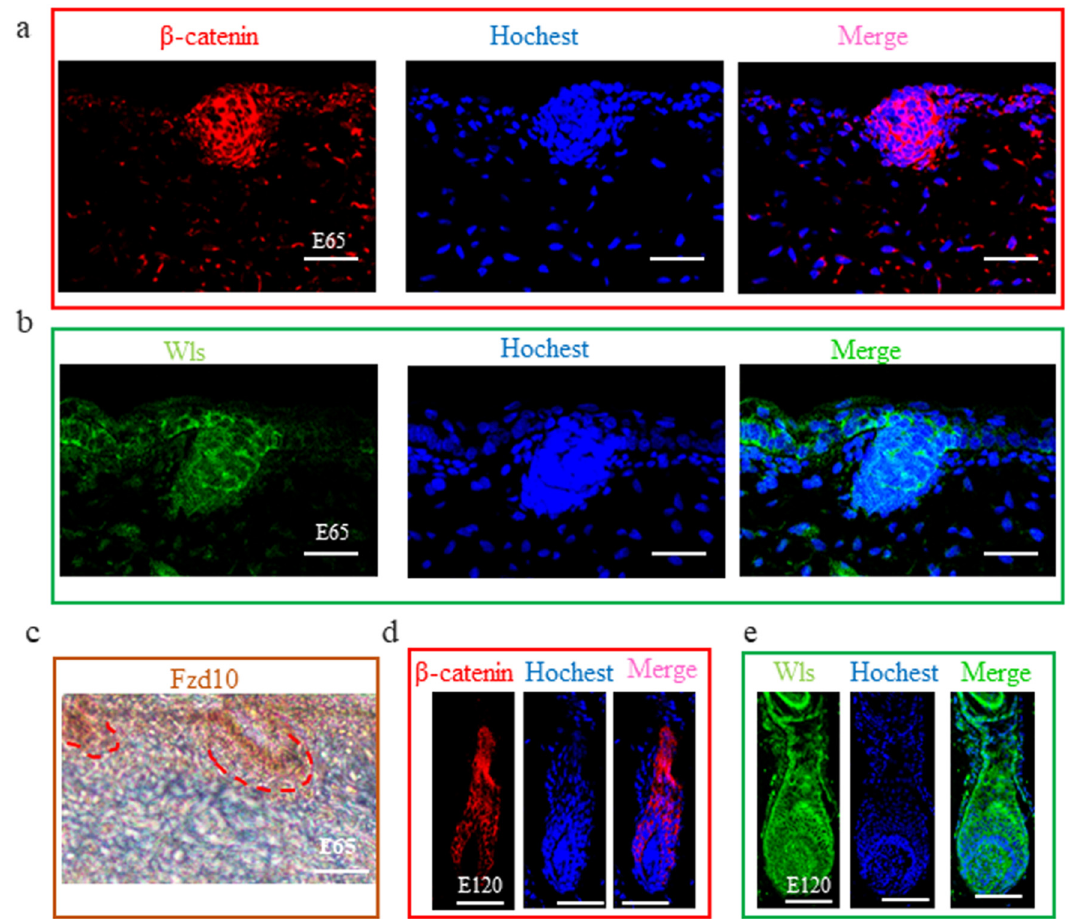
Figure 5. The expression of β -catenin, WLS, and FZD10 at hair follicle induction and differentiation stages were detected by IHC. ( a – c ) The expression of β -catenin, WLS, and FZD10 at the E 65 stage. ( d , e ) The expression of β -catenin and WLS at the E 120 stage. Both β -catenin and WLS were expressed in the epidermal hair placode at E 65 stage, suggesting that Wnt signals in the hair placode were activated under the control of the Wnt ligand from the hair placode. At E 120, β -catenin and WLS were expressed in the outer root sheath, matrix, and hair shaft. Green / red fluorescence indicated the expression pattern of the interest protein. The nucleus was stained with Hoechst in blue. Brown indicates the expression of the FZD10 protein. Red dashed lines indicate the epidermal hair follicle placode. Scale bars, 50 µm.